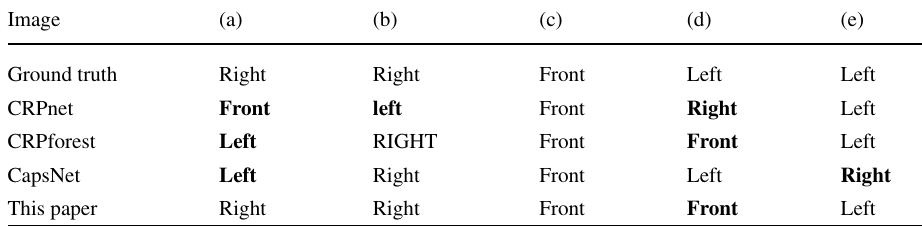
Table 7 Partial classification results of different algorithms on the Cityscapes data